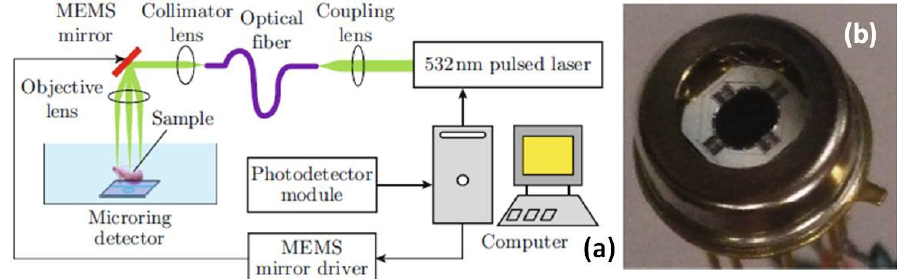
Figure 4. MEMS-based optical resolution photoacoustic microscope. ( a ) Schematic of the MEMS-based optical resolution photoacoustic microscopy (OR-PAM) system and ( b ) photography of the MEMS mirror. Reproduced with permission from [42]; published by OSA, 2012.